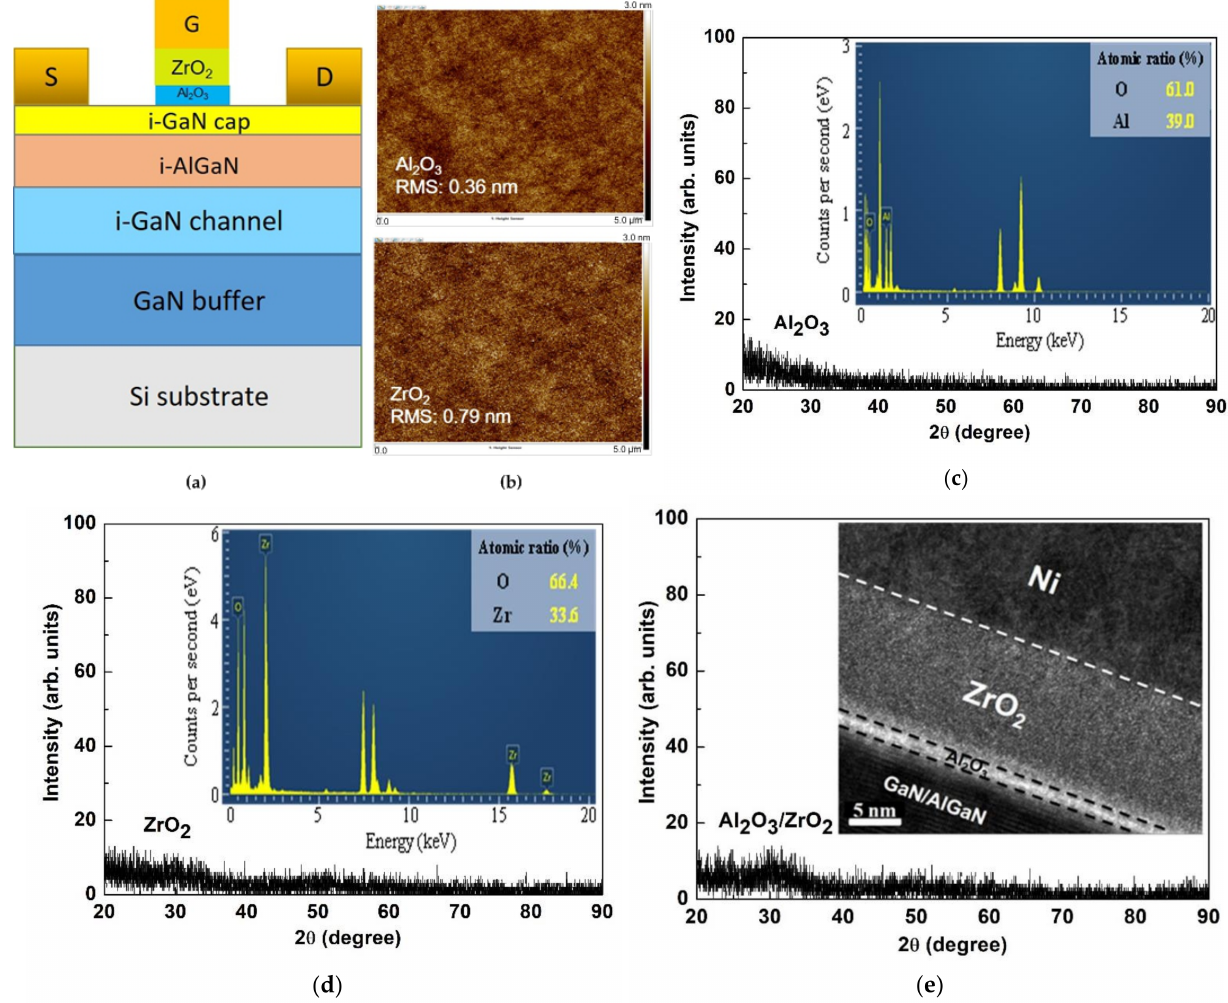
Figure 1. ( a ) Schematic structure of proposed MOS-HEMT; ( b ) AFM images of Al 2 O 3 and ZrO 2 ; ( c – e ) XRD spectra of the Al 2 O 3 , ZrO 2 , and Al 2 O 3 /ZrO 2 , respectively. The insets of ( c , d ) show the related EDS spectra. The inset of ( e ) shows the TEM image of the Al 2 O 3 /ZrO 2 stacked layer. Figure 2a shows the drain current density (I DS ) versus drain voltage (V DS ) characteris- tics of the Schottky-gate HEMT for reference and the proposed Al 2 O 3 /ZrO 2 stacked-layer MOS-HEMT, respectively. The corresponding static on-state resistance (R on ) are 6.21 Ω · mm and 3.82 Ω · mm at gate voltage (V GS ) = 0 V in the linear region, respectively. The maximum I DS of the stacked layer MOS-HEMT is 847 mA/mm at V GS = 5 V, which is higher than that (676 mA/mm at V GS = 3 V) of the Schottky-gate HEMT owing to the high- κ oxide layer. Figure 2b shows the comparison of transconductance (g m ) and I DS of Schottky-gate HEMT and stacked-layer MOS-HEMT at 4 V of V DS . The g m values are 134 mS/mm and 181 mS/mm, respectively. The corresponding threshold voltages (gate swing voltages) are − 3.19 V (2.21 V) and − 3.88 V (3.02 V), respectively. The threshold voltage is determined as the V GS intercept of the linear extrapolation of the drain current at the point of peak g m . For example, the red dotted line in Figure 2b intersects the horizontal axis. The